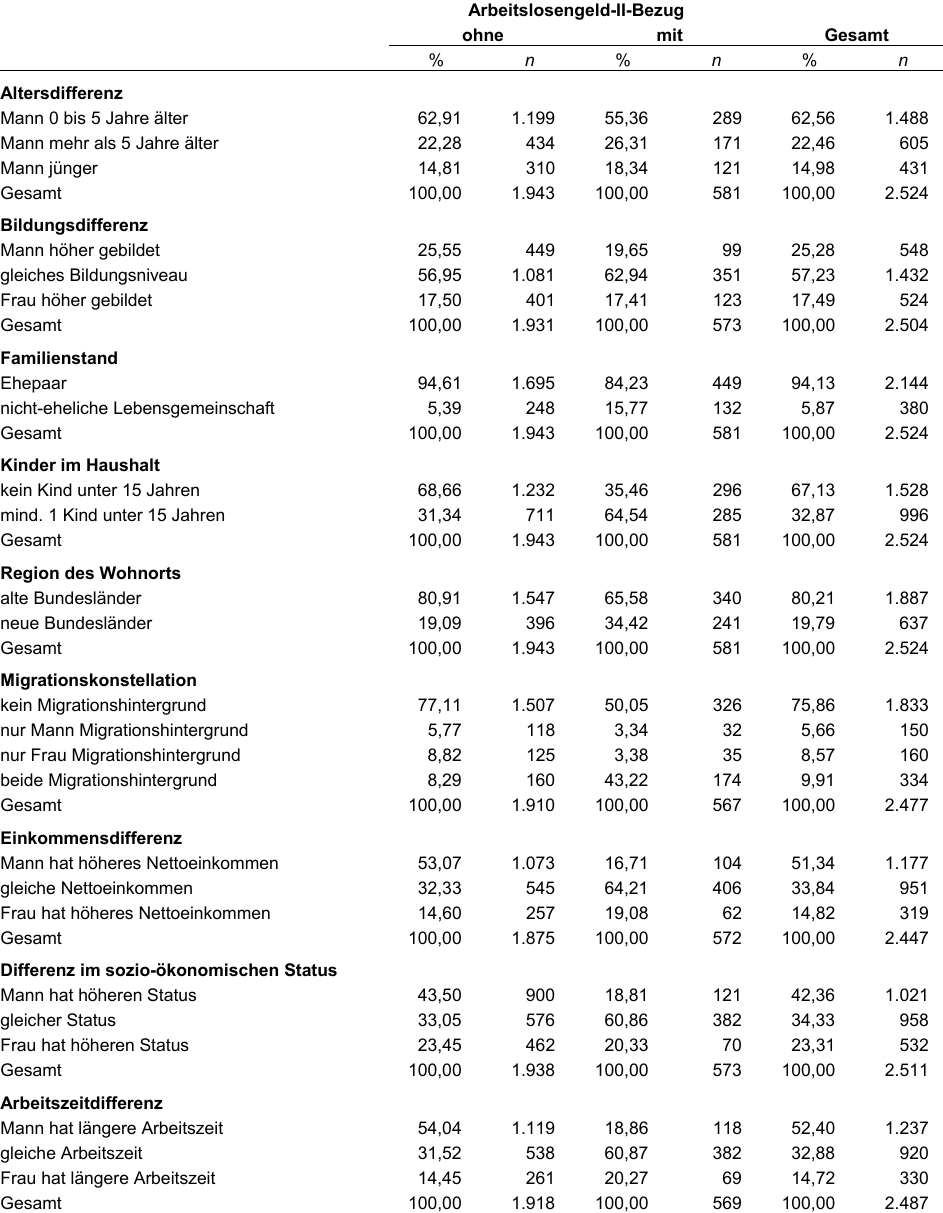
Tabelle 6: Beschreibung des Analysesamples (dyadische Paarebene